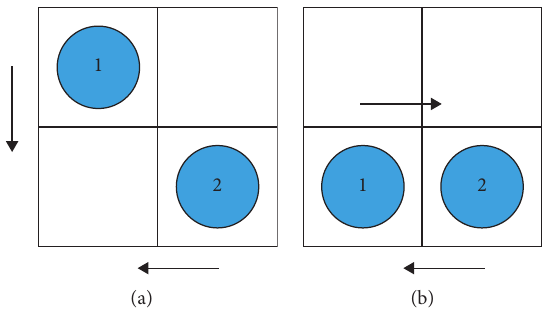
Figure 2: Restricted condition for motions of multiple robots in